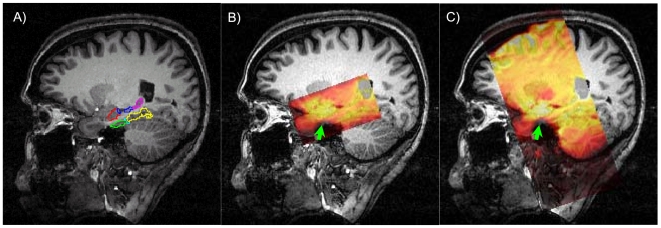
Region of interest definition and alignment of zoomed and full field of view (FOV) EPI with reference 3D MP-RAGE volume anatomy.(A) ROI definitions, shown on a parasagittal section: red = anterior hippocampus (aHIPP); blue = middle hippocampus (mHIPP); magenta = posterior hippocampus (pHIPP); green = entorhinal cortex (ER); cyan = perirhinal cortex (PR: not seen in this section); yellow = posterior parahippocampal gyrus (PHG). (B) Location of zoomed EPI volume (after automated alignment); EPI images are shown as a partially transparent overlay with a hot colormap. Signal loss due to through-slice gradients is apparent where gray matter in anterior parahippocampal regions is visible on the underlying anatomical image (green arrow). (C) For full FOV, high-resolution EPI volume increased distortion is evident in anterior parahippocampal gray matter (slice thickness and in-plane resolution are equated, so drop-out is equivalent for EPI data shown in (B,C). Low-resolution EPI data (not shown) covered the same field of view as the high-resolution EPI data shown in (C).